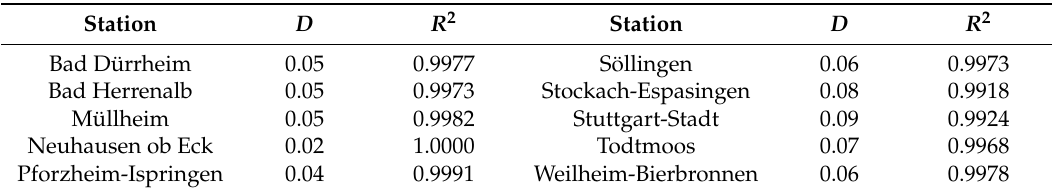
Table 5. Performance measures from the comparison of modeled cumulative distribution function (CDF mod ) with empirical cumulative distribution function (CDF emp ) associated with U 100m time series included in